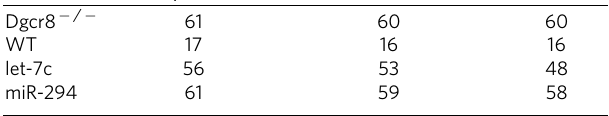
Table 1 | Number of samples under each condition following each filter.